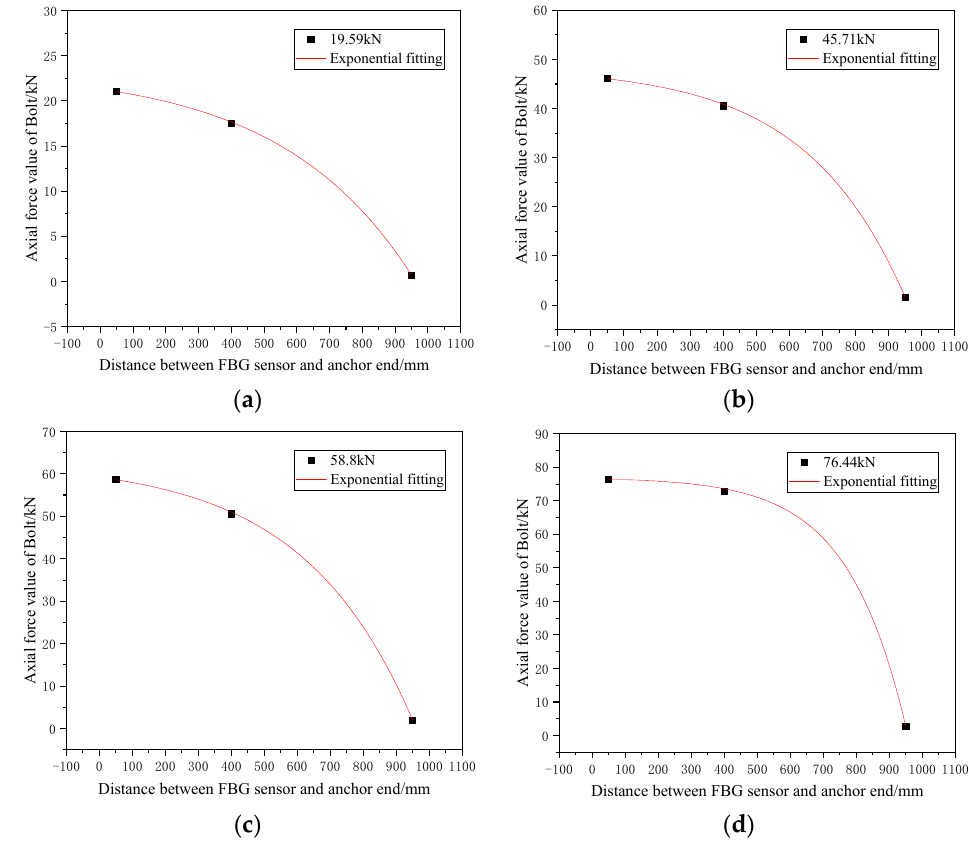
Figure 12. Axial force-fitting curve of bolt at loading force of ( a ) 19.59 kN, ( b ) 45.71 kN, ( c ) 58.8 kN, and ( d ) 76.44 kN. Table 2. Fitting parameters of bolt axial force under different load conditions.